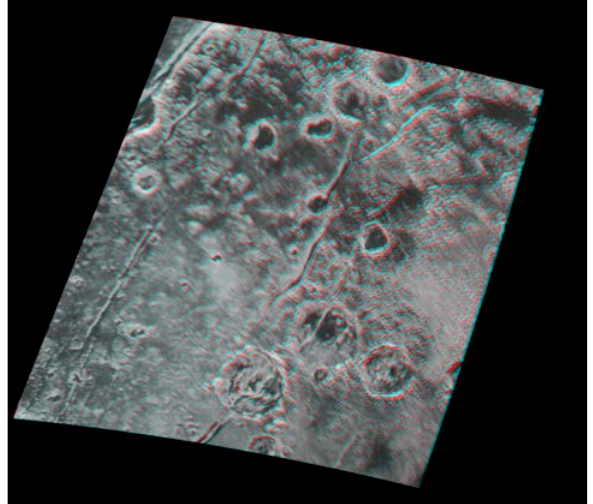
Figure 2b. A high-resolution 3d anaglyph of Pluto over cratered and fractured terrains near Pluto’s equator. The deepest canyons are ~3 km deep. Largest craters are ~45 km across.